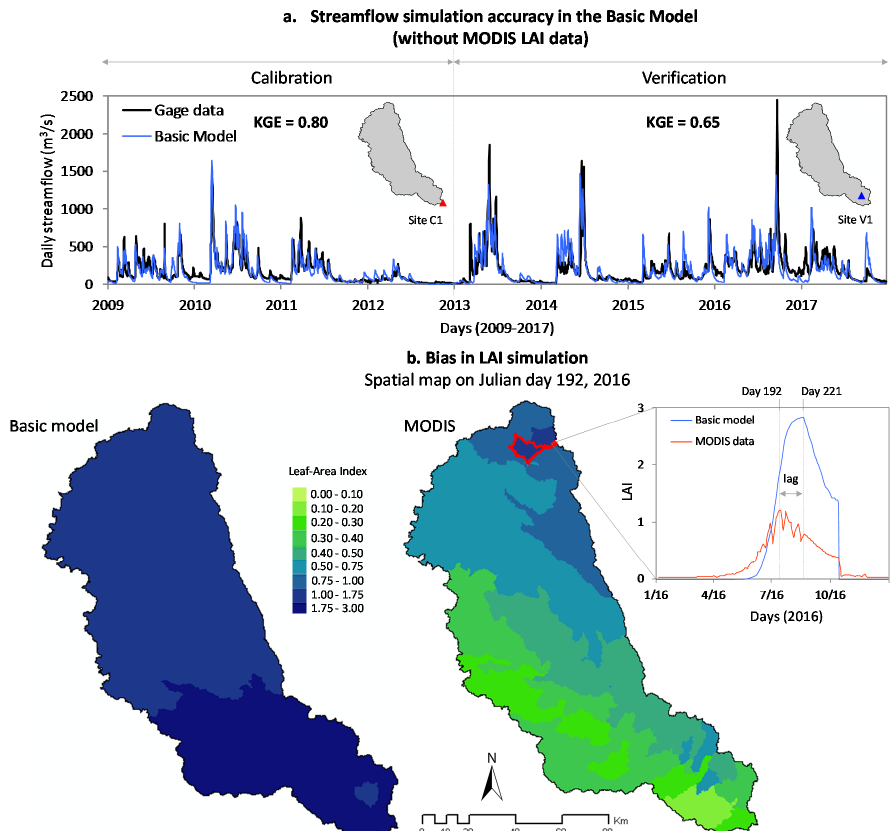
Table 2. Evaluation of model performance in daily streamflow simulation. KGE = 1 means 100% agreement between simulated and reference data.